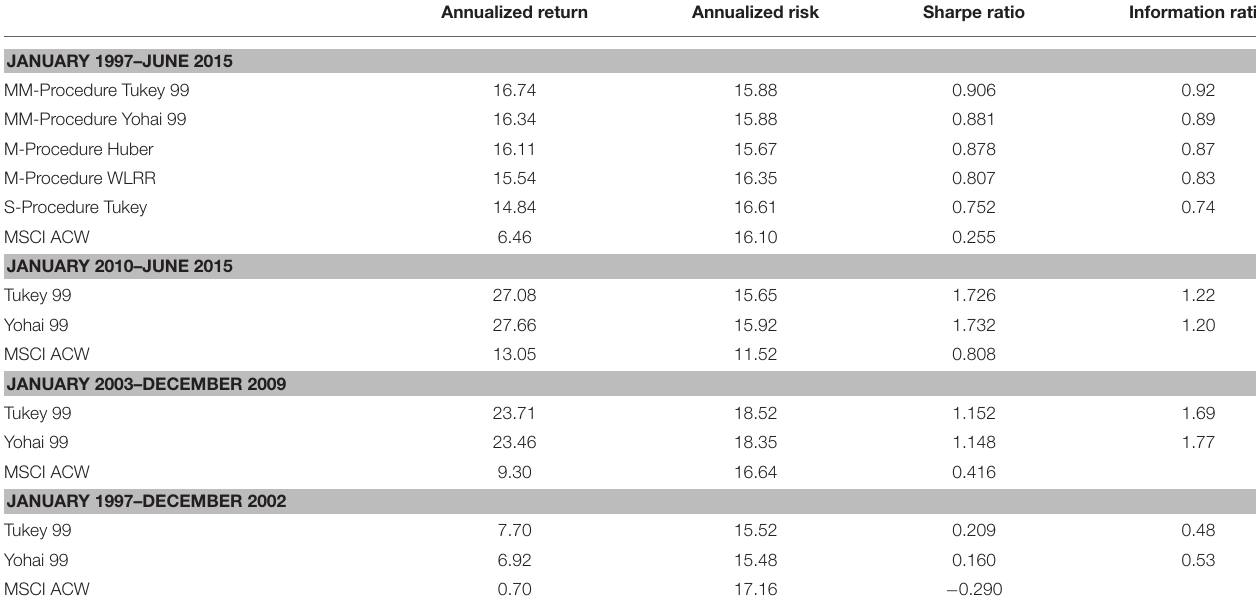
TABLE 9 | Global broad regression BackTest summary